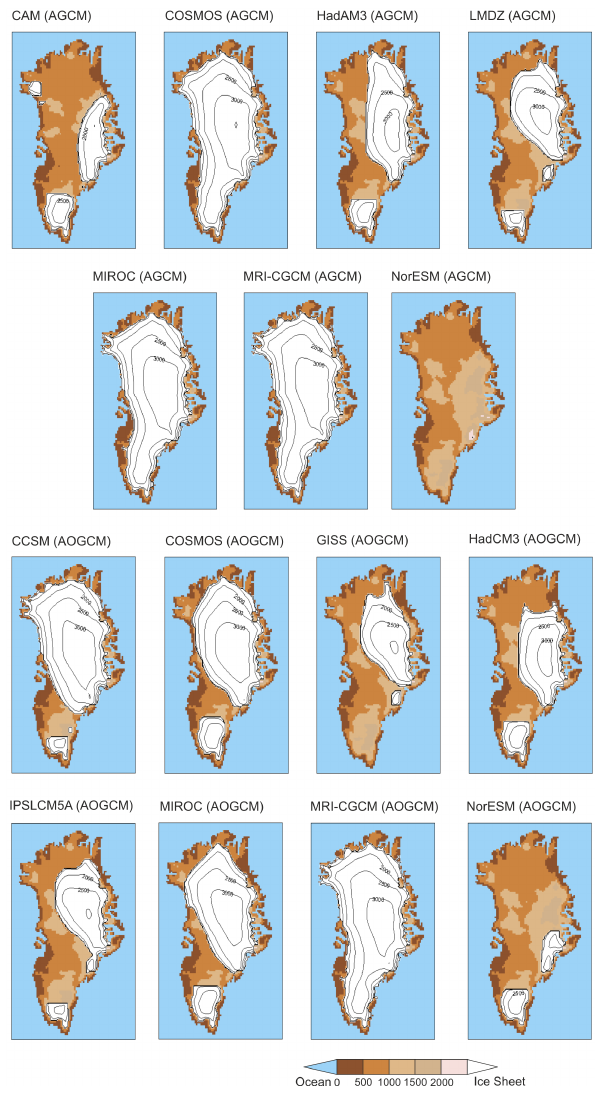
Figure 9. BASISM reconstructions of the mPWP GrIS for individ- ual AGCM and AOGCM forcings. All BASISM simulations were forced with climate model fields (i.e. temperature and precipitation) that were downscaled by a bilinear interpolation method from the original model grid to 20km × 20km resolution. GCM specific to- pography was also used and the ISM simulations were initialised from the PRISM3 ice sheet configuration (Fig. 1). The ice sheet con- figurations relate to the volumes (red-filled circles) shown in Fig. 7 which use standard glaciological